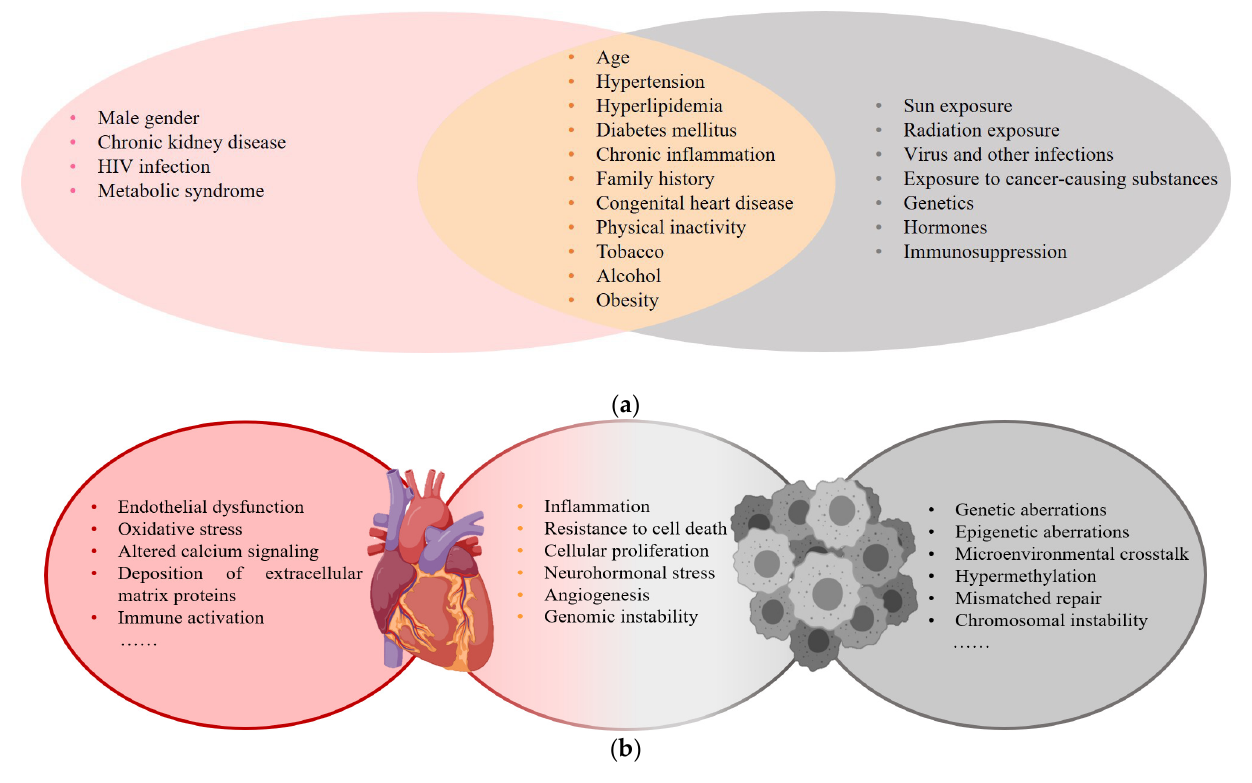
Figure 1. ( a ) Risk factors for CVD and cancer; ( b ) Common pathophysiologic processes of CVD and cancer.